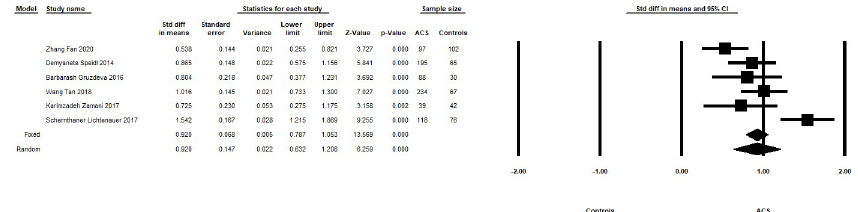
Fig 4. Summary forest plots showing the Meta-SMD and 95% CI of sST2 levels in ACS patients and healthy controls. The Meta-HR in the random effects model is shown by the black diamond at the bottom. The vertical line at 1 is the border for significance.